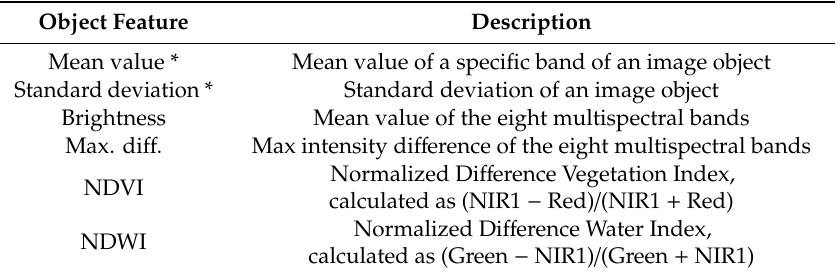
Table 1. Object features used for initial segmentation and